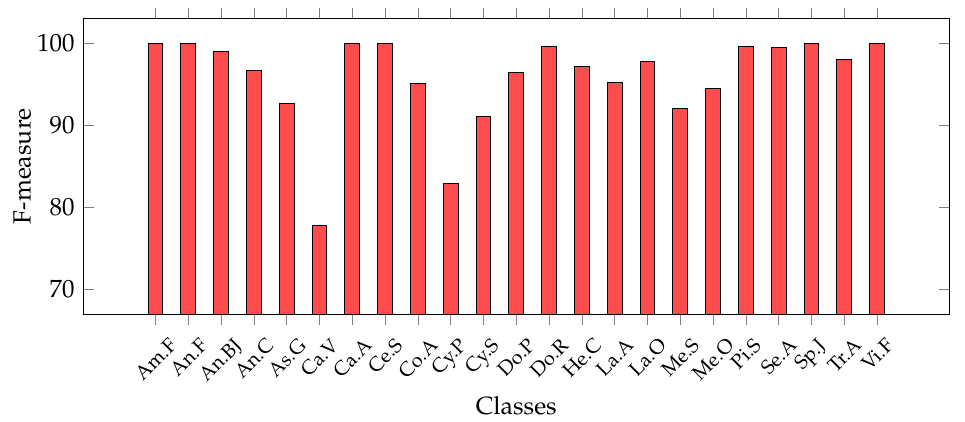
Figure 9. Classwise MFM on the best model for the Cagliari data set, trained with deep features: SVM with SeedNet features.